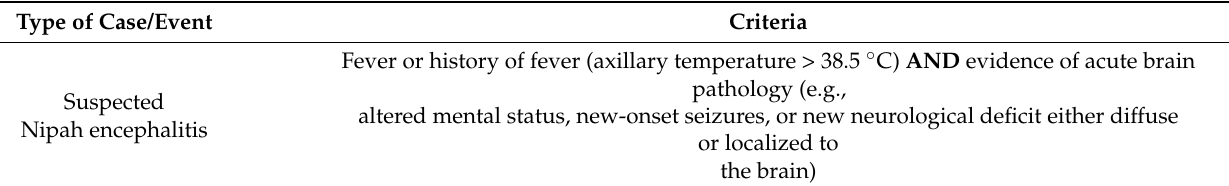
Table 1. Surveillance case definitions of human NiV infection and